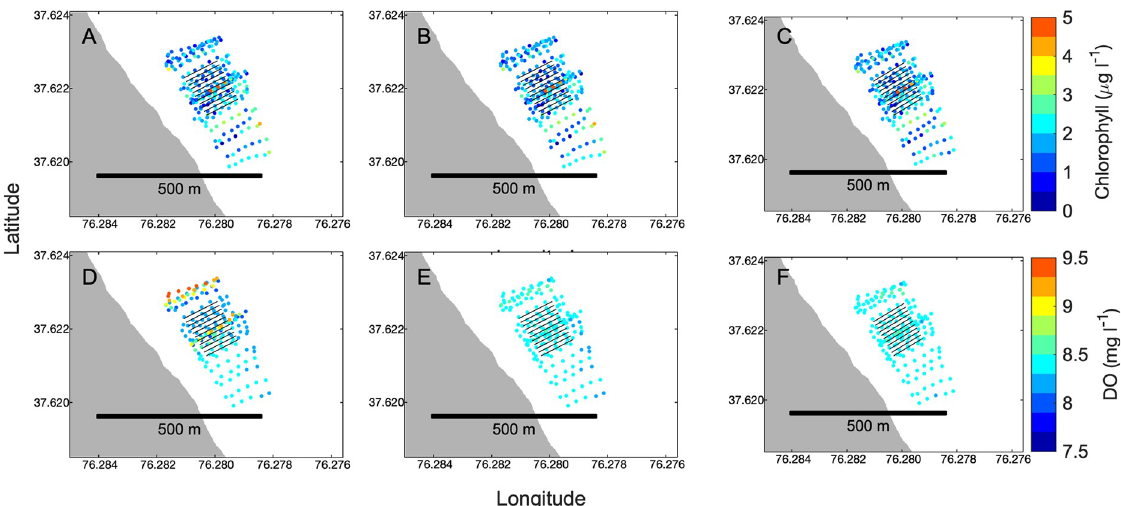
Fig 4. Examples of water quality measurements before and after detrending. On the top row, the color of points indicates chlorophyll concentration ( μ g l -1 ) at Windmill Point in summer 2017, (A) before detrending for either time or salinity, (B) after detrending for time, before detrending for salinity, and (C) after detrending for both time and salinity. On the bottom row, the color of points indicates DO concentration (mg l -1 ) (D) before detrending, (E) after detrending for time, and (F) after detrending for both time and salinity. For chlorophyll every 7 th point is shown, and for DO every 9 th point is shown, corresponding with the subsampling interval for those variables on this cruise (Table 2). https://doi.org/10.1371/journal.pone.0224768.g004 start points. Full details of the autocorrelation analysis used to determine subsampling inter- vals can be found in this study’s data repository [54]. Once data were subsampled, a combination of 2- and 3-way analyses of variance (ANOVA) were used to assess the effects of location with respect to the farm footprint (inside vs. outside), site, season, and their interactions on current speed, chlorophyll, turbidity, and DO. A two- way factorial ANOVA with four levels of site (i.e. Windmill Point, Bland Point, Monday Creek, and Broad Bay), and two levels of location relative to farm (inside vs. outside) was used to assess the effects of these factors on data collected in summer 2017. We then assessed the effects of season in addition to other factors using a three-way factorial ANOVA with two lev- els of site (Windmill Point and Broad Bay), two levels of season (summer and fall), and two levels of location relative to farm (inside vs. outside). When significant interactions between terms were identified, additional analyses were carried out within levels of factors and factor combinations as appropriate. When a factor was identified as significant, post-hoc testing Table 2. Median limiting lags used for subsampling for each variable on each cruise.